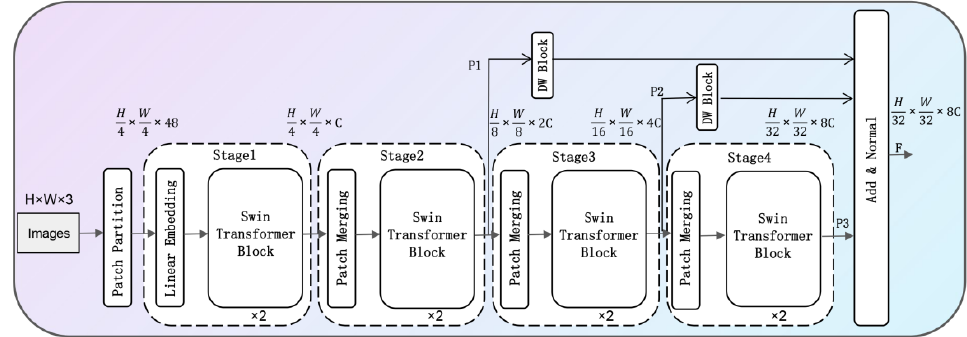
Figure 4. MS Transformer module structure.